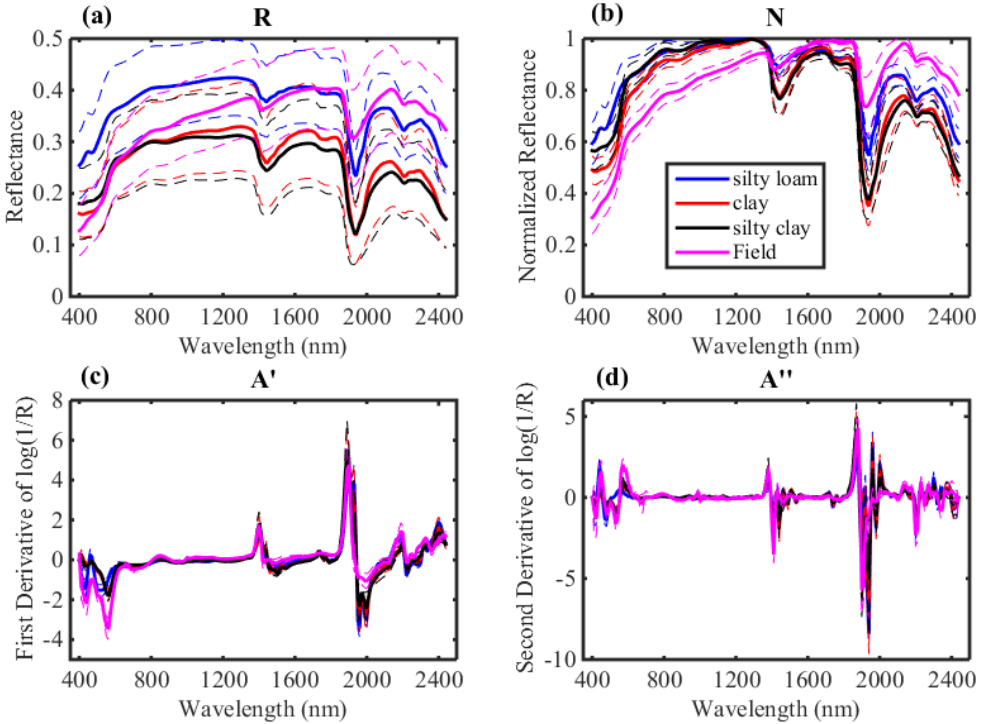
Figure 2. Mean hyperspectral reflectance values of ( a ) Reflectance (R); ( b ) Normalized Reflectance (N); ( c ) First Derivative of log(1/R) (A ′ ) and ( d ) Second Derivative of log(1/R) (A ″ ) for silty loam (blue), clay (red), silty clay (black) and Field samples (purple). Dash lines indicate positive or negative standard deviation values from the mean value. The hyperspectral data in figure c and d is standardized to unit variance.